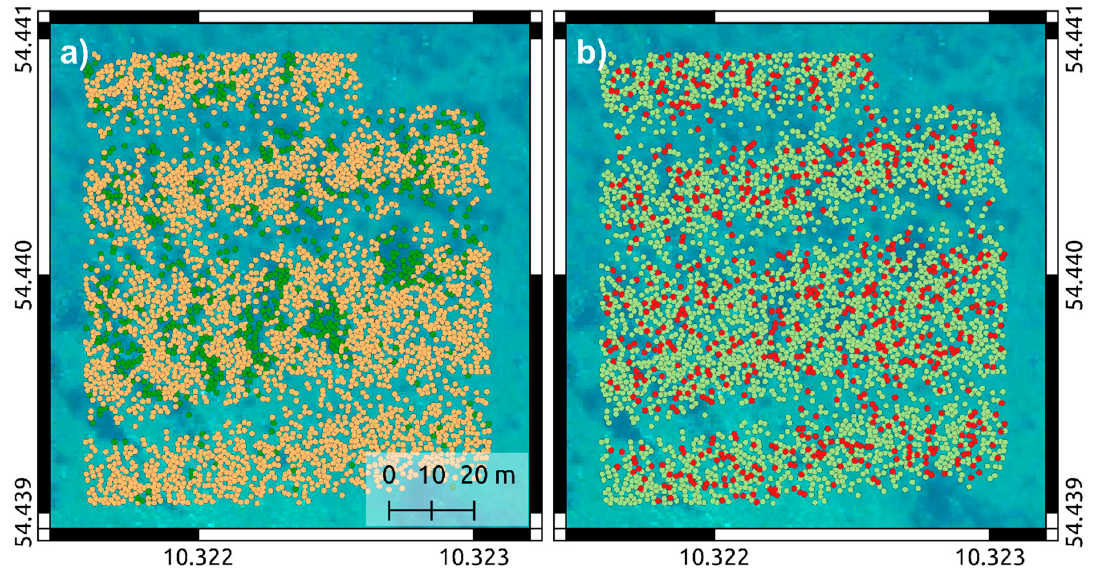
Figure 2. Aerial view of SA2: ( a ) with randomly chosen but a least 1m apart samples points, green points are manually labeled as SAV and orange ones are identified as seafloor returns; ( b ) same sample points but now split into RF training points (light green) and RF test points (red).